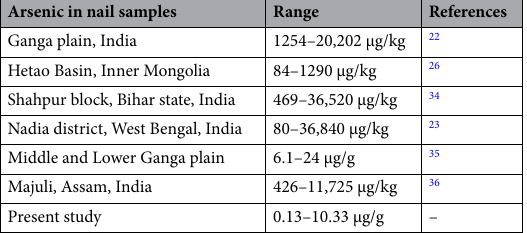
Table 4. The concentration of arsenic in nail samples collected from different